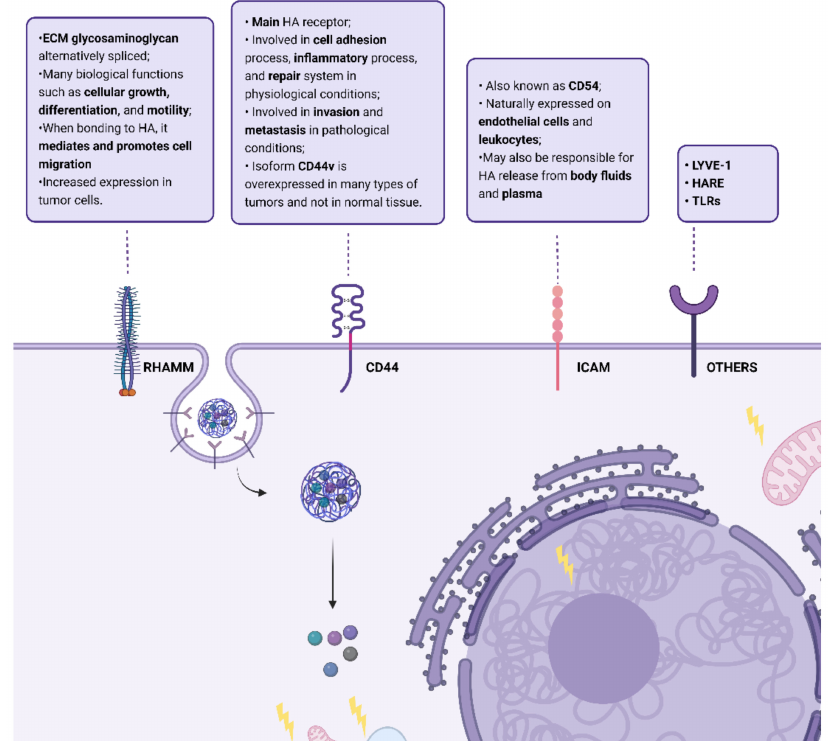
Figure 2. Summary of HA cell surface receptors: cluster of differentiation 44 (CD44), receptor for hyaluronic acid-mediated motility (RHAMM), Intercellular Adhesion Molecule 1 (ICAM); lymphatic vessel endothelial hyaluronan receptor (LYVE-1), hyaluronic acid receptor for endocytosis (HARE), and Toll-like receptors (TLRs) and some of their actions when bonded to HA. Created with “https: //biorender.com/, accessed on 28 September